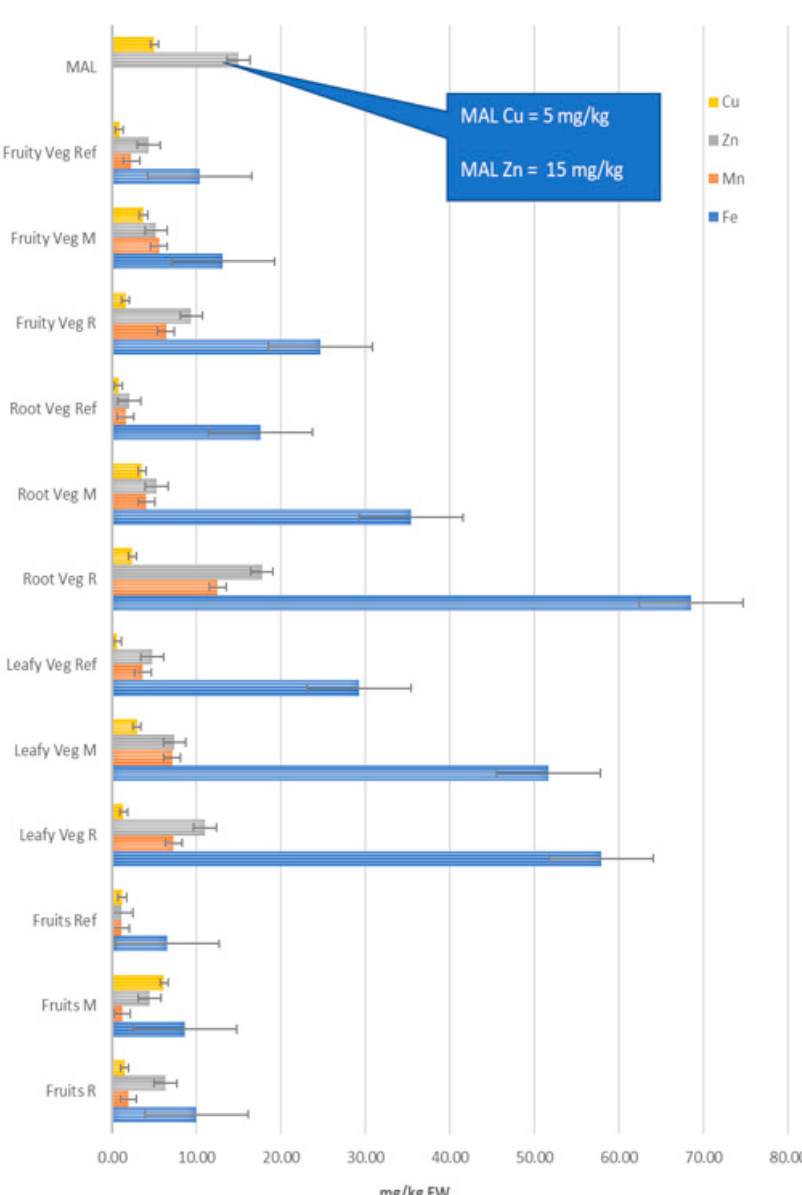
Figure 2. Concentrations of Fe, Mn, Zn and Cu (mg/kg fresh weight (FW)) in different groups of vegetal foodstuffs.